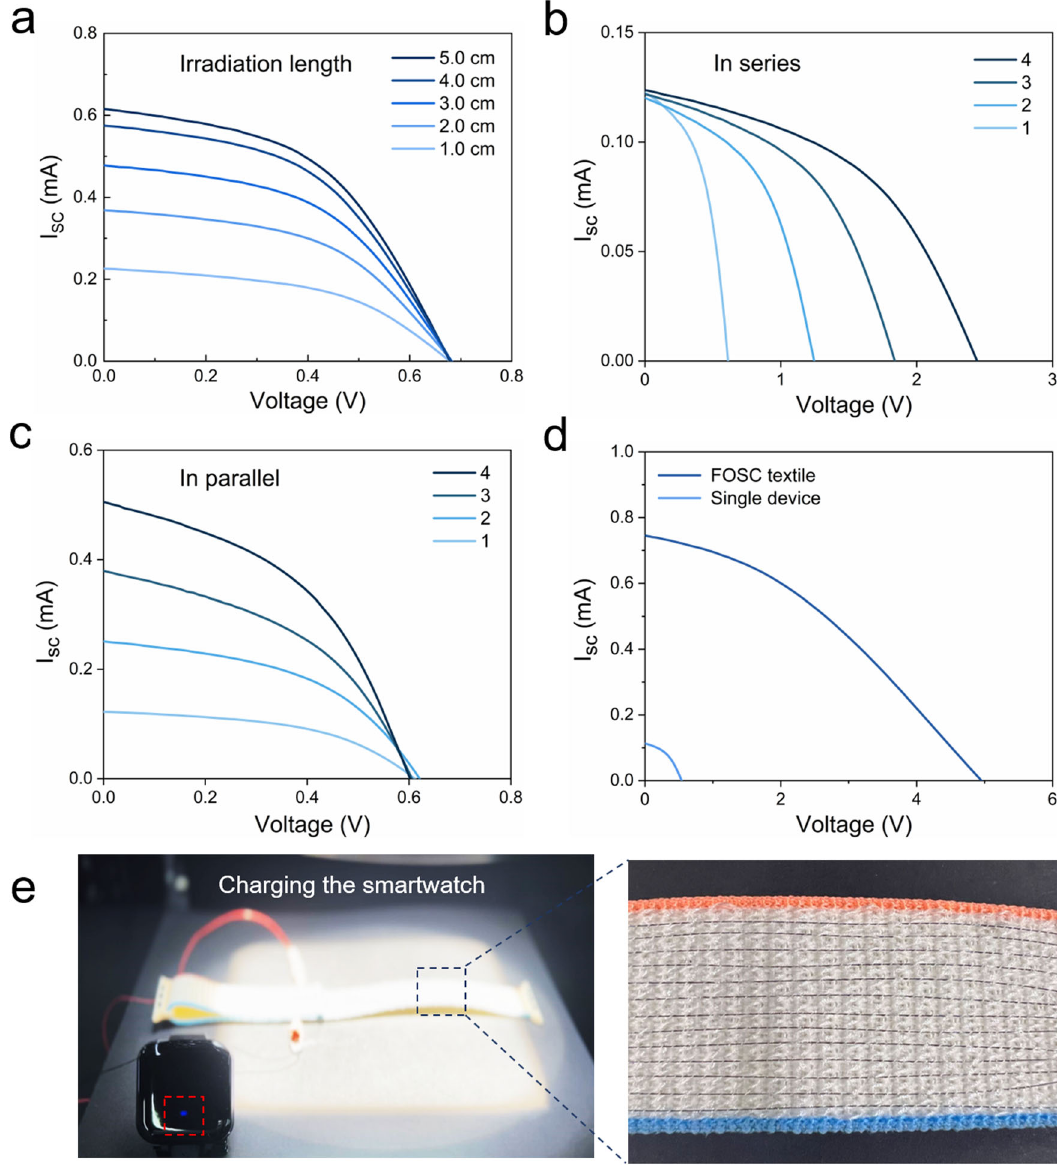
Fig. 5 FOSCs connected in series or parallel to enhance the output power. Photovoltaic performance of the FOSCs a varying in irradiation length, b connected in series, and c connected in parallel. d Photovoltaic performance of the wearable textile weaved with FOSCs. e The watchband weaved with the FOSCs used to charge the